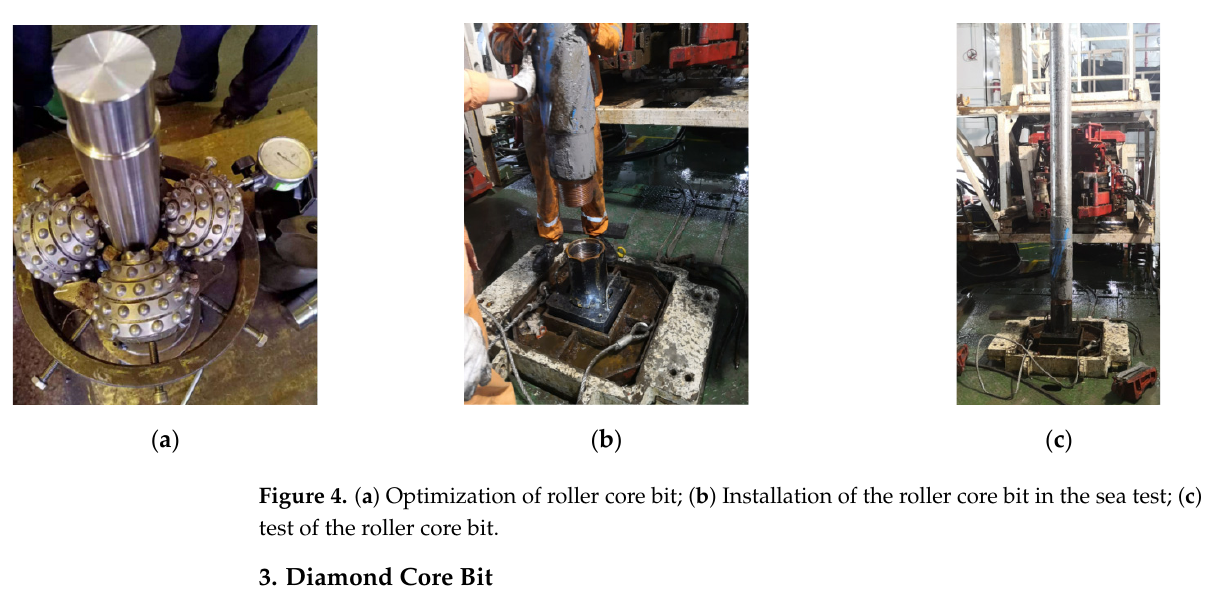
( c ) Figure 5. Schematic diagram of lip structure of diamond drill bit. ( a ) Bottom ‐ flat shape; ( b ) Cusp concentric ‐ circled shape; ( c ) Cusp ‐ staggered shape.